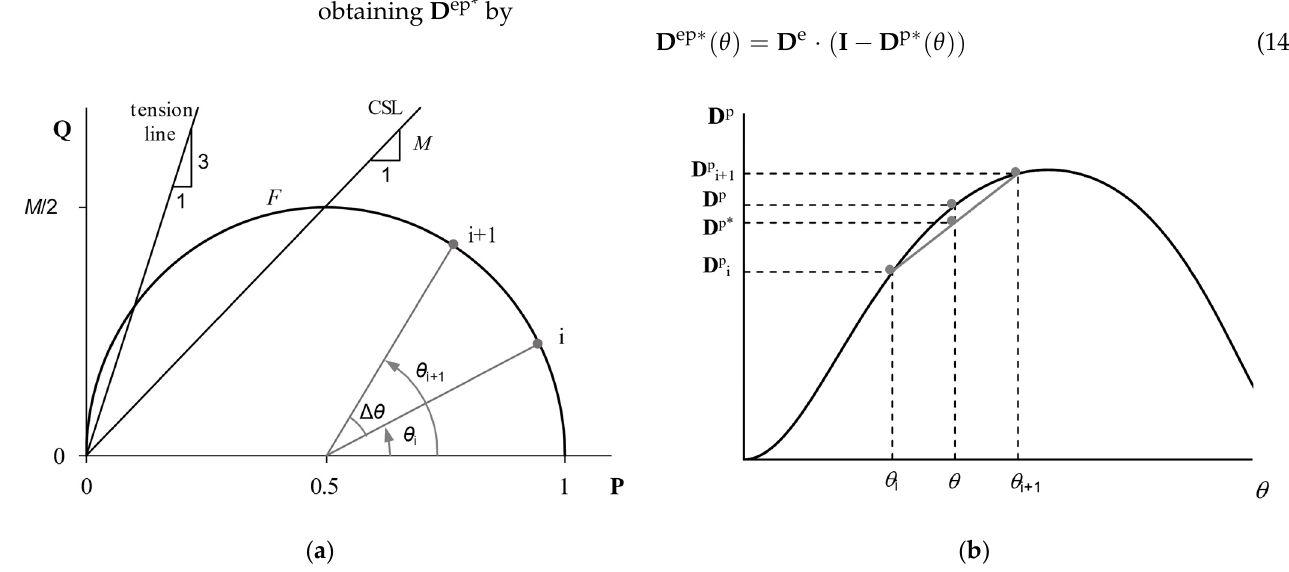
Figure 2. ( a ) Discretization of the dimensionless yield surface as a function of the angle θ , including the position of the tension line. ( b ) Diagram of the interpolation strategy. Note that for simplicity, the interpolation of the plastic matrices is represented in one-dimensional space.